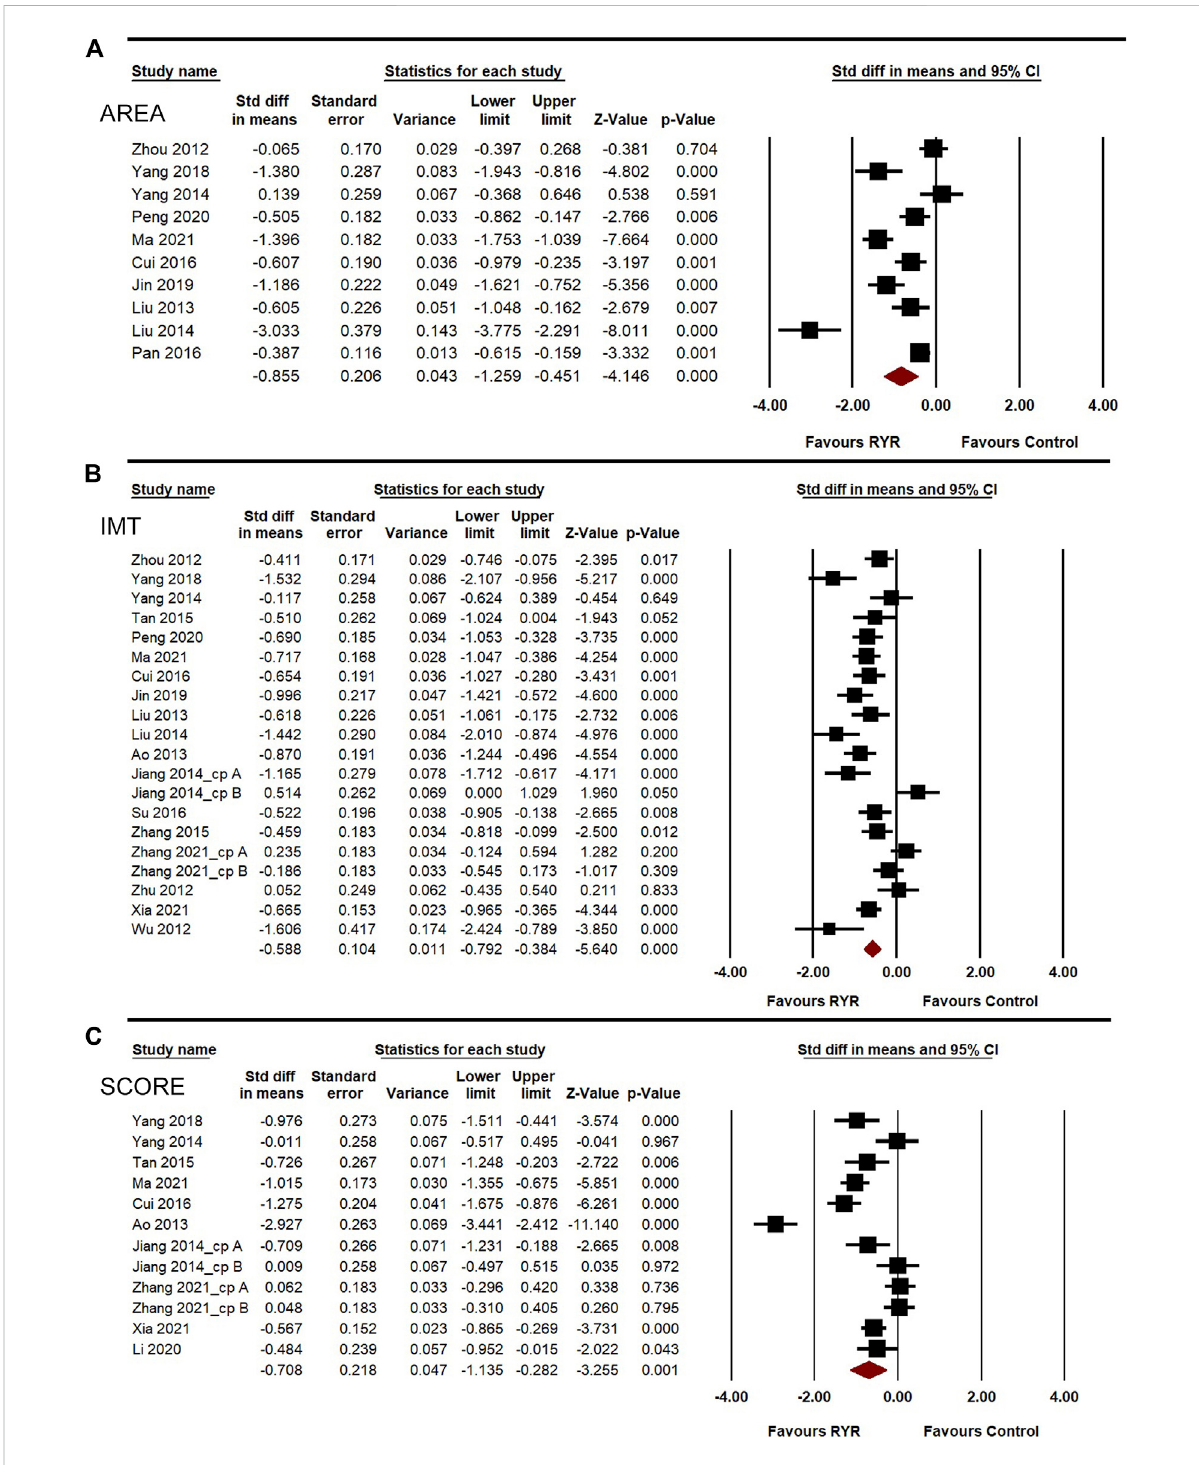
FIGURE 3 Meta-analysis of the effects of RYR therapy on AREA (A) , IMT (B) , and SCORE (C)